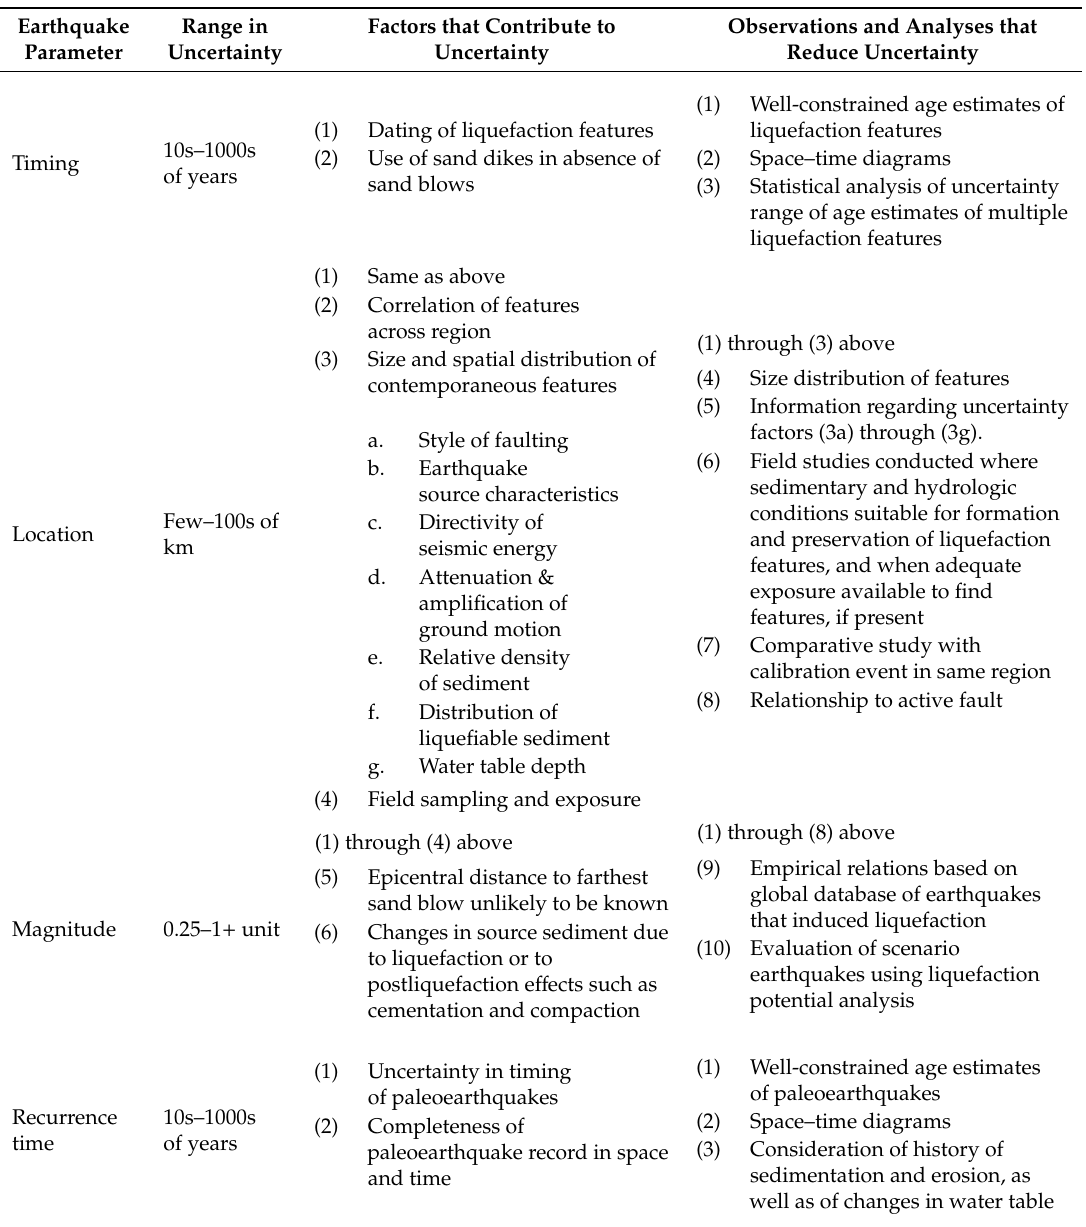
Table 2. Uncertainties related to interpretation of liquefaction features